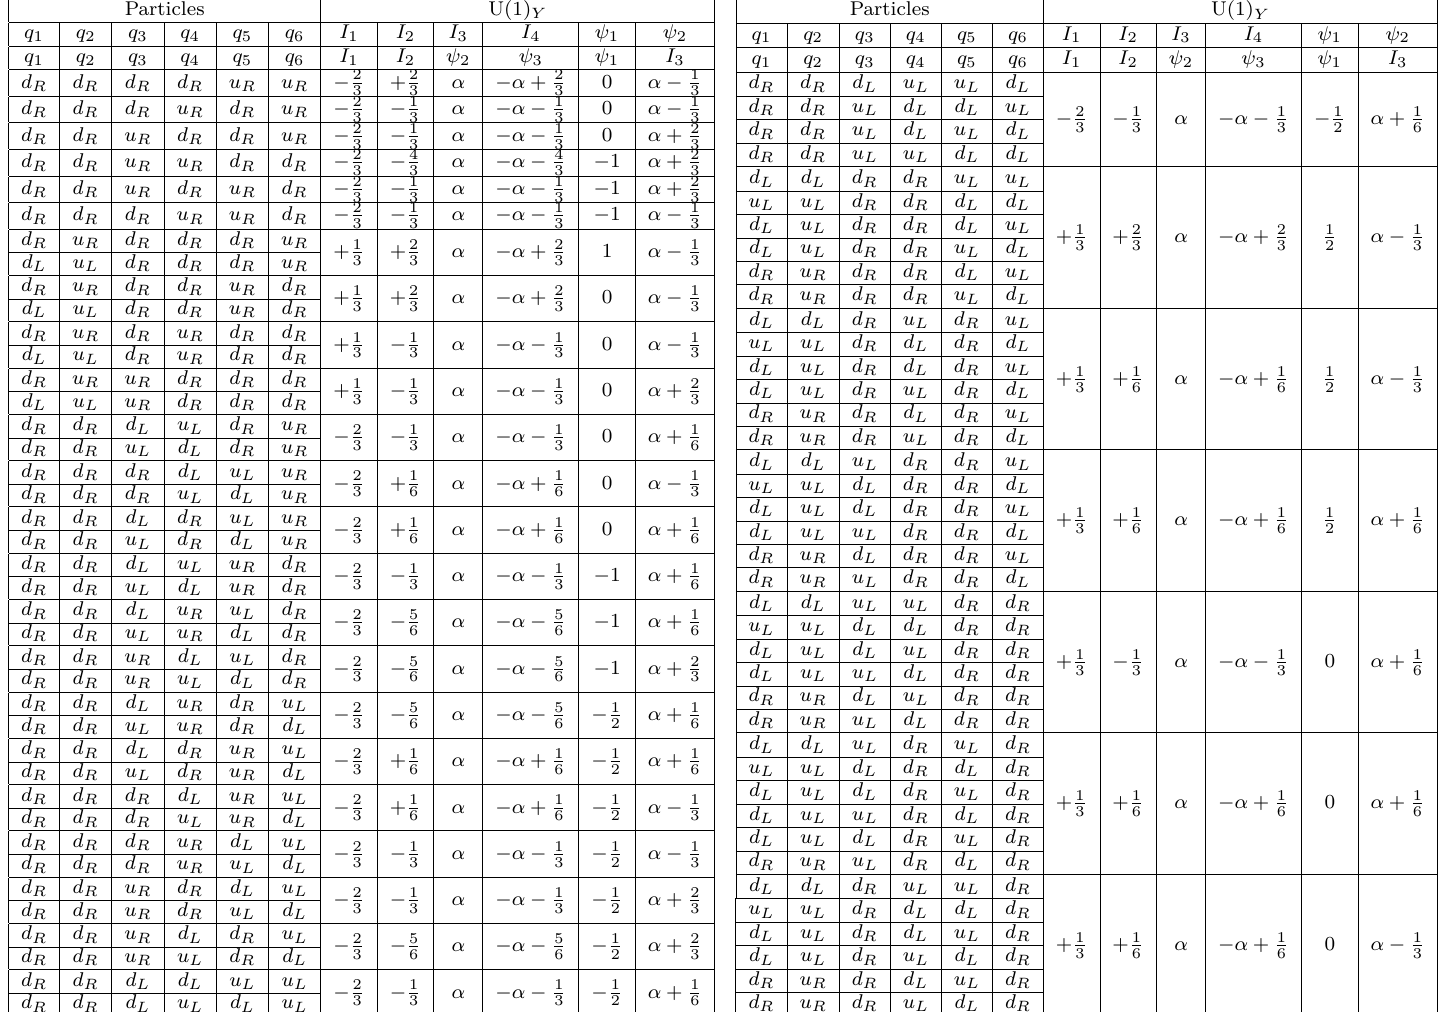
Table 19 . The possible quantum numbers of the fields in Topology-L-15 and